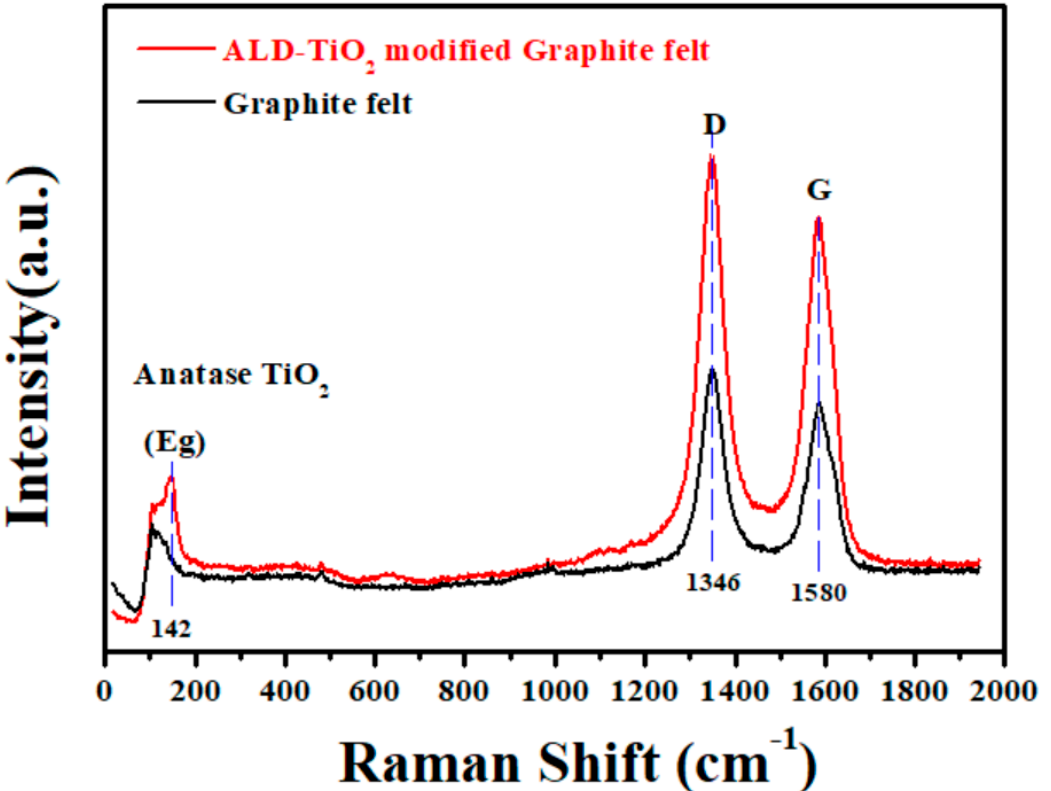
Figure 6. Raman spectra of original graphite felt and ALD-TiO 2 -modified graphite felt.